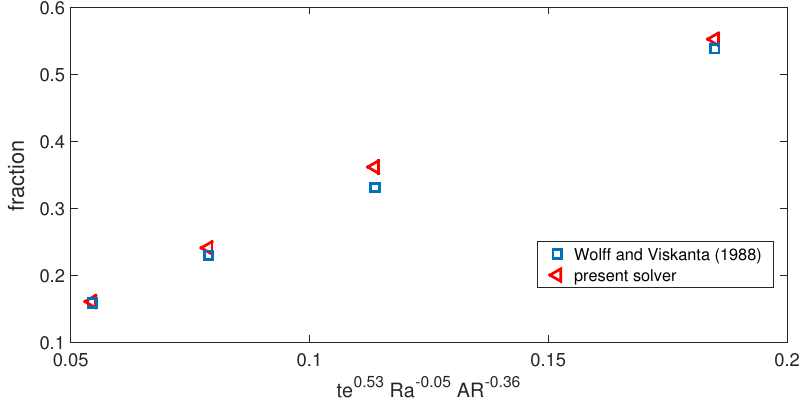
Figure 3. Comparison results (with [60]) for fraction of the solidified volume at various times for Ph-C process in a differentially heated